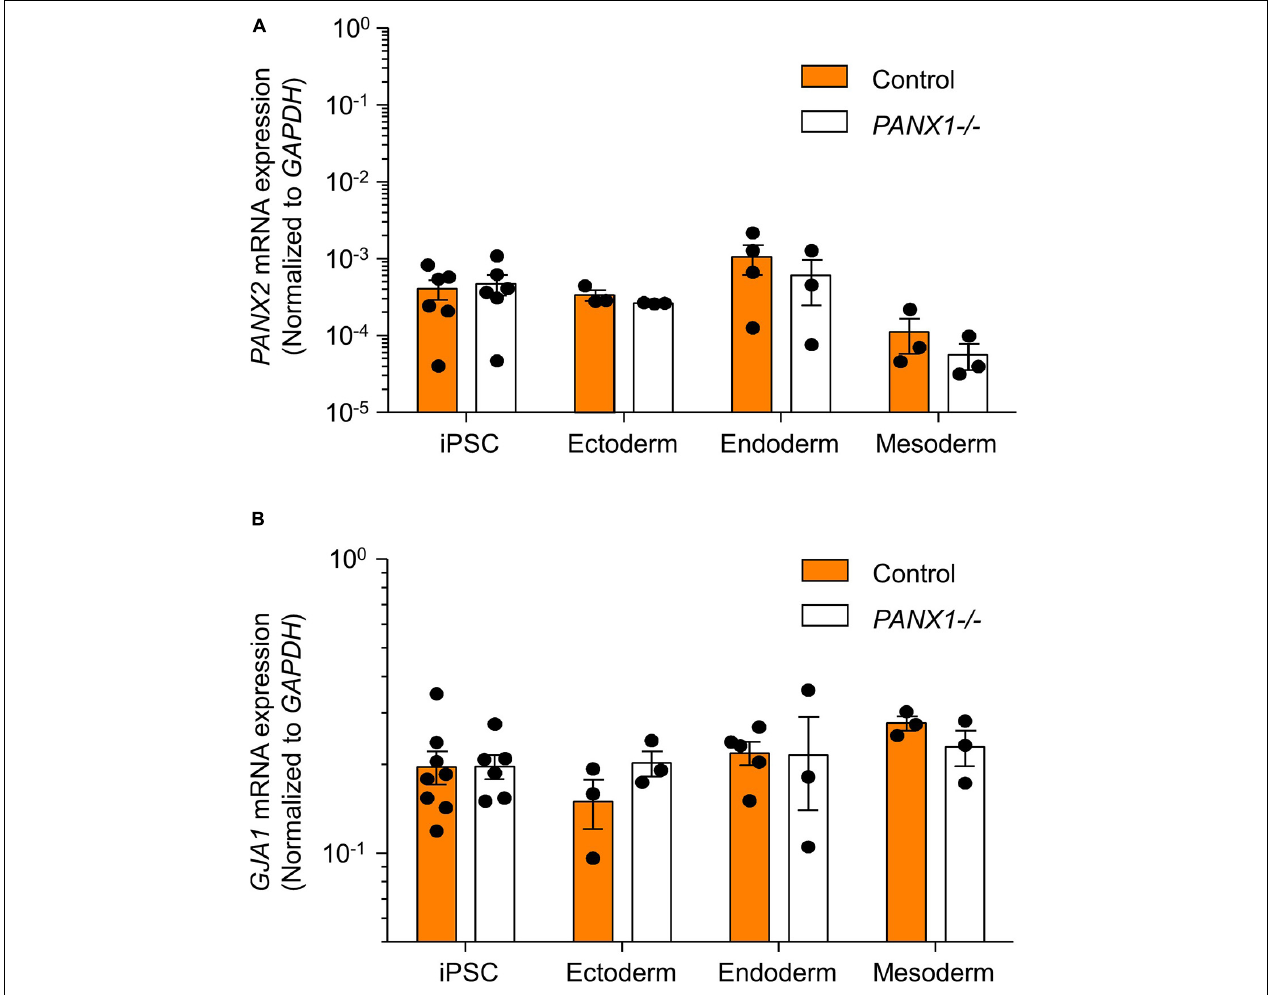
FIGURE 8 | PANX2 and Cx43 do not compensate for PANX1 loss during germ lineage differentiation. qPCR analysis of (A) PANX2 and (B) GJA1 (Cx43) mRNA expression in directed ectoderm, mesoderm, and endoderm cultures. Data presented as 2 - (cid:49) CT (fold change from GAPDH ) and represent the standard error of the mean of 3-8 independent